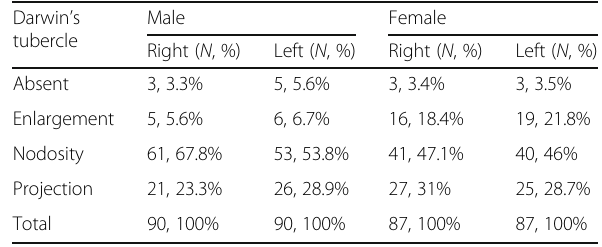
Table 7 Frequency of Darwin ’ s tubercle in males ( N = 90) and females ( N = 87)